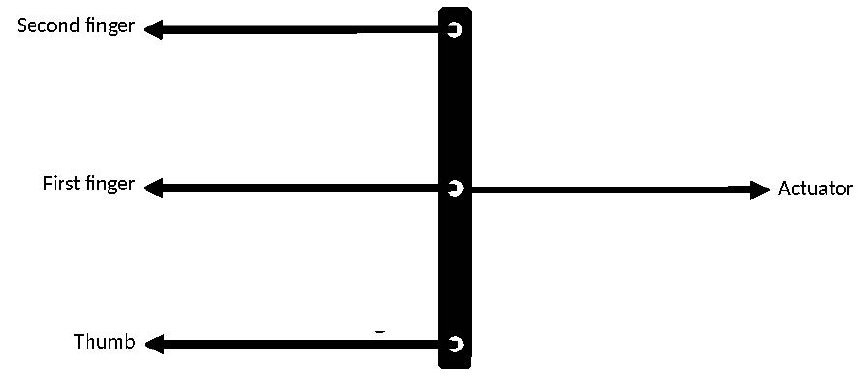
Figure 5. Whippletree mechanism proposed by Makerhand